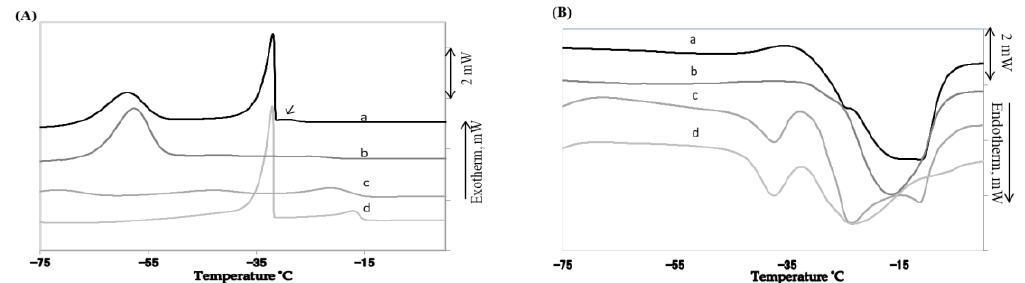
Figure 4. ( A ). Thermal behavior with DSC during cooling at a rate of 5 ° C/min: (a) RoM; (b) rapeseed oil; (c) soybean oil; and (d) SoM from 0 to − 75 ° C. ( B ) Thermal behavior with DSC (Differential Scanning Calorimetry) during melting at a rate of 5 ° C/min: (a) rapeseed oil; (b) RoM; (c) SoM; and (d) soybean oil from − 75 to 0 ° C.